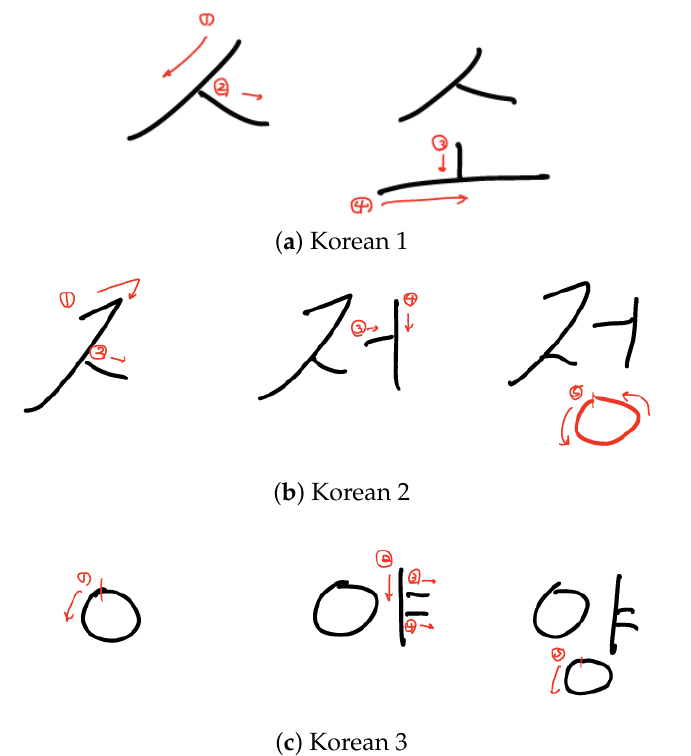
Figure A3. Drawing patterns of the ‘Korean’ drawing pattern used in this